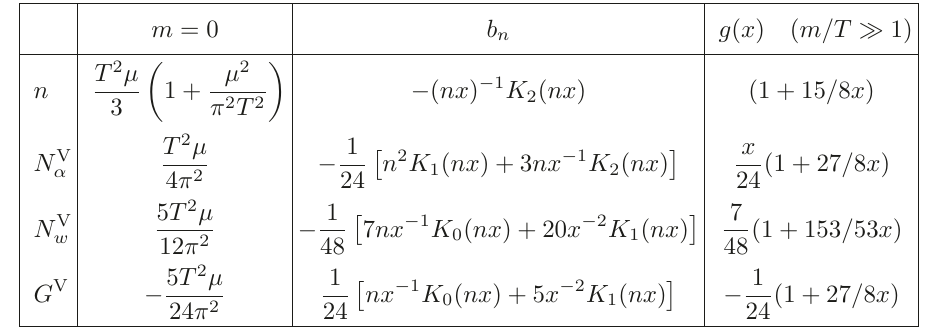
Table 3 . The vector current coefficients (6.3) for an ideal boson field: the first column is the result at m = 0 and µ = 0, the second column is the generic terms of the series expansion (8.4), the third column is the asymptotic expansion for low temperature (8.5).